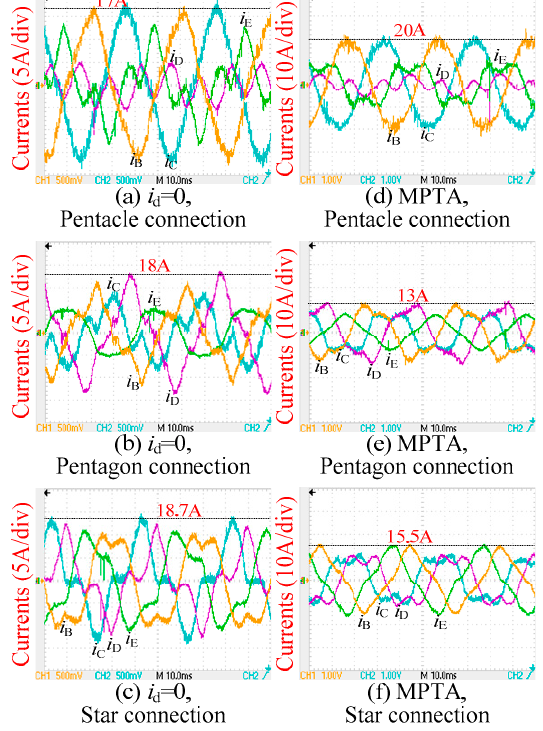
Figure 10. Actual winding phase currents under a single open-line fault.